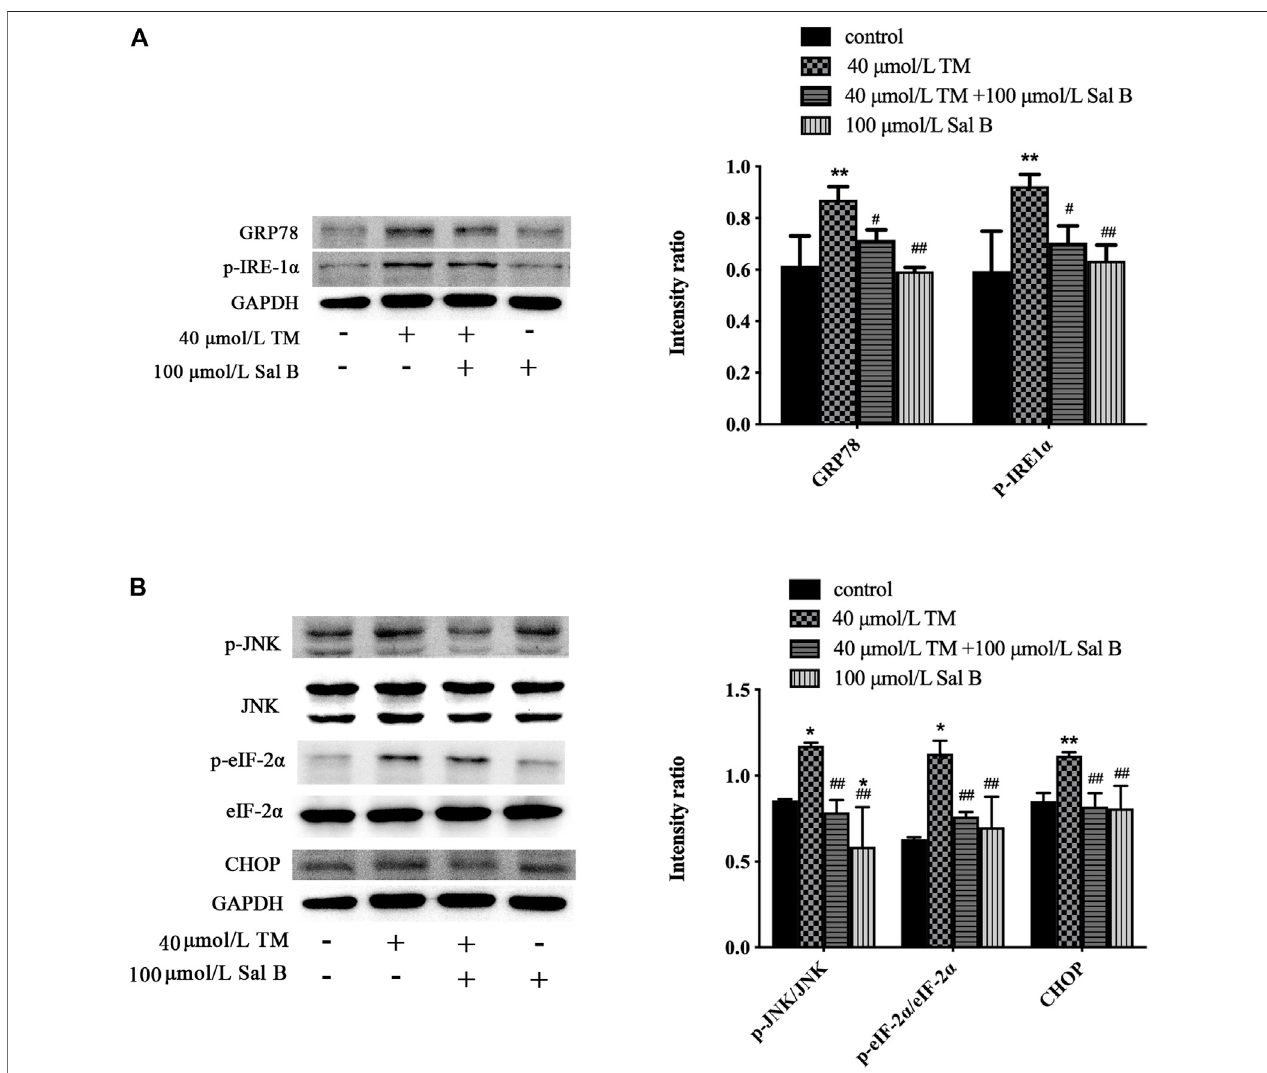
FIGURE 9 | Sal B signi fi cantly reduced the level of ERS-related proteins induced by TM. (A) Sal B reduced the levels ofGRP78 and p-IRE-1 α . (B) Sal B decreased the levels of p-JNK/JNK, p-eIF-2 α /eIF-2 α , and CHOP. The data were determined by ANOVA and LSD post-hoc test and are presented as the mean ± SD ( n (cid:1) 3). * P < 0.05, ** P < 0.01 vs. control group; # P < 0.05, ## P < 0.01 vs. TM